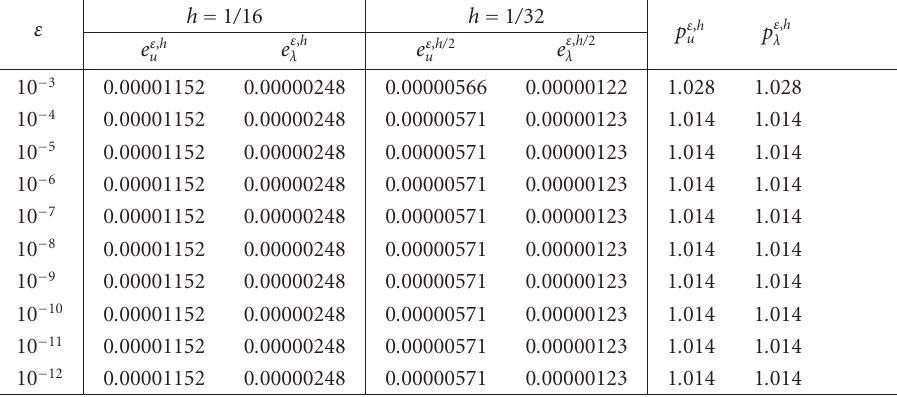
} and convergence rates { p ε , h , e ε , h u λ